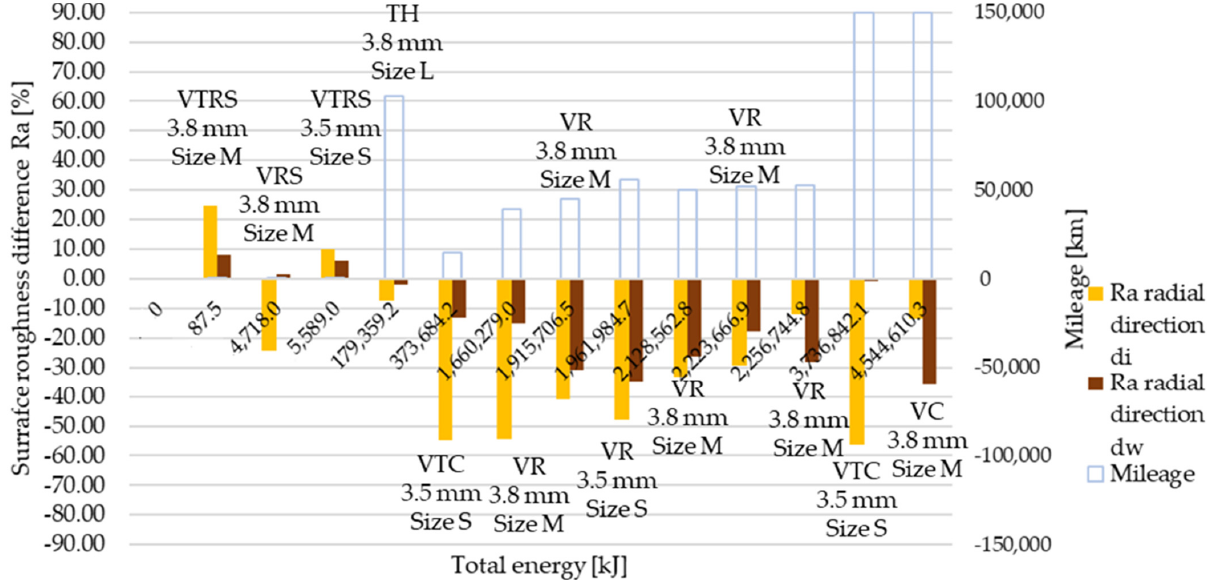
Figure 12. Deviation of Ra surface roughness values from initial conditions, radial direction.